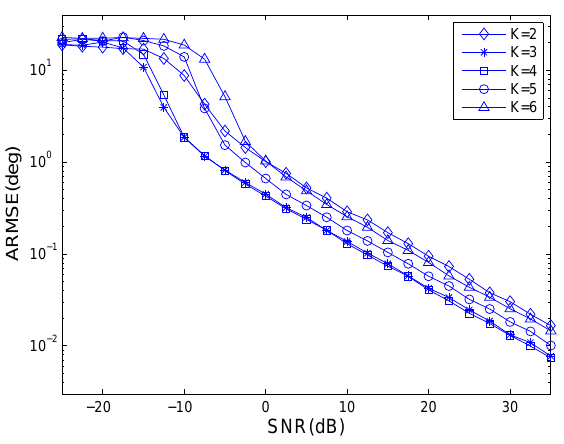
Figure 5. ARMSEs of angle estimation versus the number of overlapped-transmit-subarrays